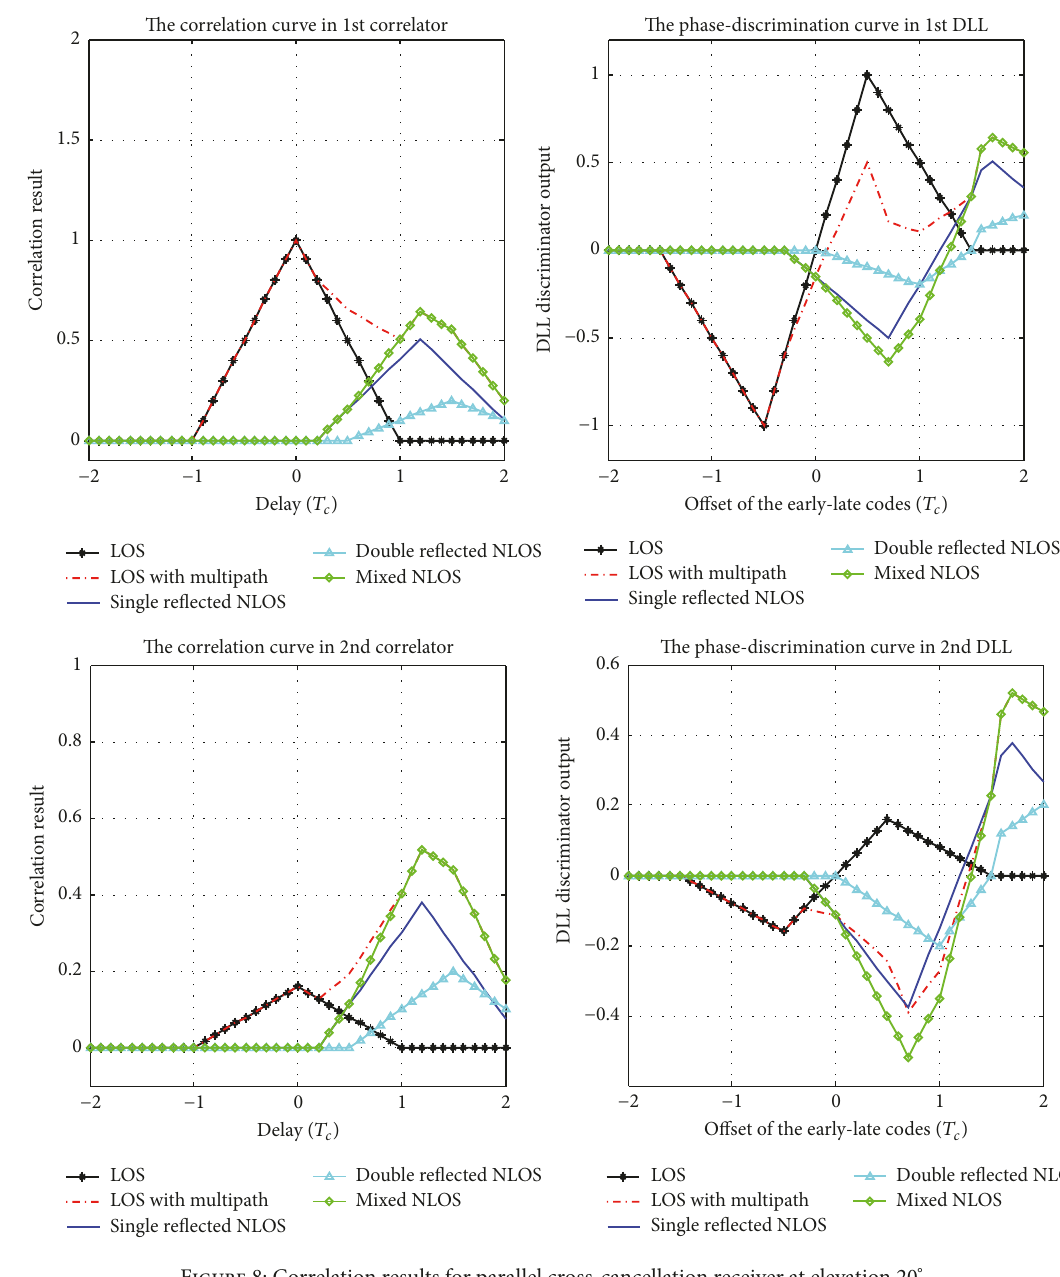
Figure 8: Correlation results for parallel cross-cancellation receiver at elevation 20 ∘